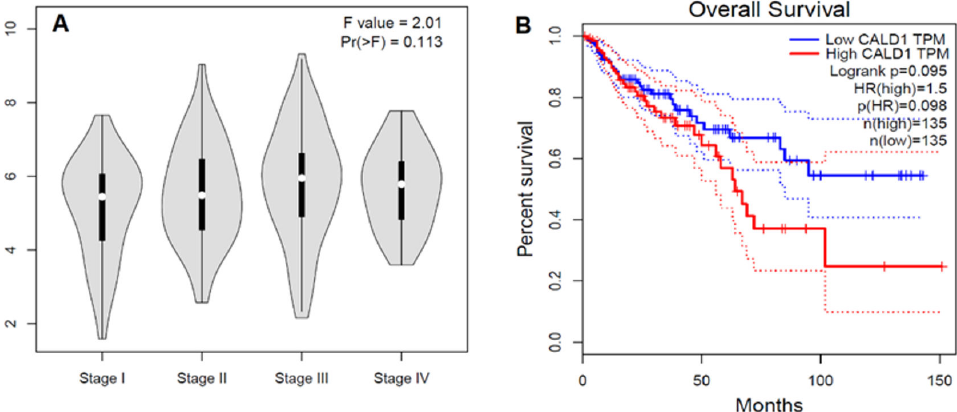
Figure 4. In silico analysis of CALD1 genes in the TCGA colon adenocarcinoma cases. ( A ) Stage plot showing CALD1 gene expression in various tumor stages of the colon adenocarcinoma cohort of the TCGA dataset ( n = 275). ( B ) Kaplan–Meier survival curve shows the overall survival analysis of the cases of TCGA colon adenocarcinoma according to CALD1 gene expression status. The solid line represents the survival curve and the dotted line represents the 95% confidence interval; HR = 1.5; p (HR) = 0.98, n = 270. The study was performed using GEPIA at http://gepia.cancer-pku.cn/index. html (accessed on 1 December